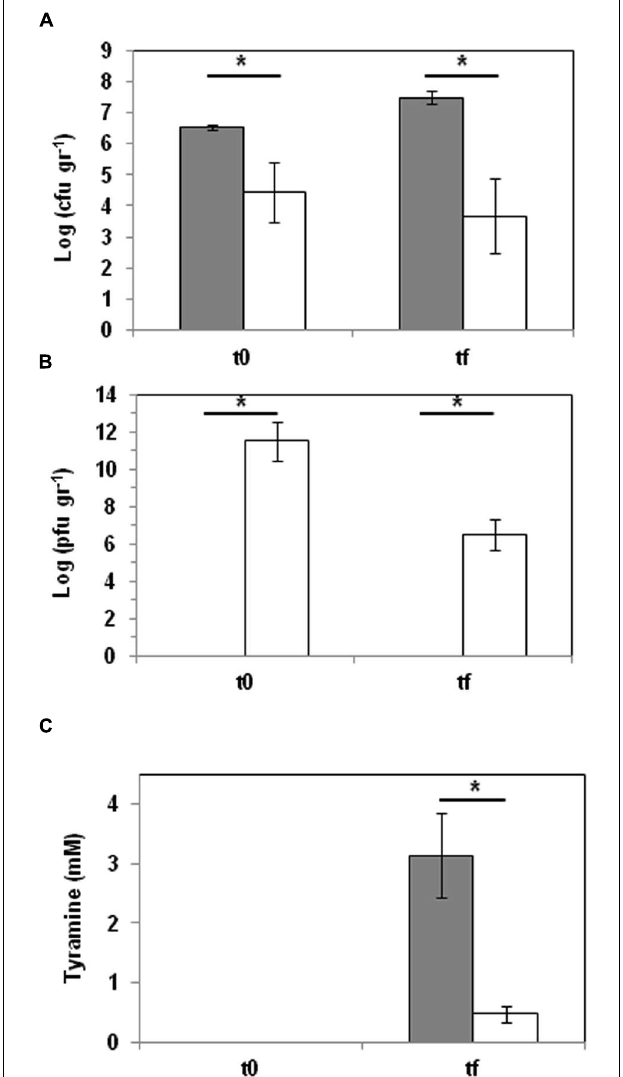
FIGURE 4 | Phage biocontrol assay in a small-scale cheese model. E. faecalis was challenged with phage Q69 at an MOI of 0.1 (dark gray bar = control cheeses inoculated with E. faecalis 23a; white bar = cheeses inoculated with E. faecalis 23a and challenged with phage Q69). (A) Number of E. faecalis cells (log cfu ml − 1 ) after manufacturing (t0) and after 60 days of ripening (tf), as calculated by qPCR. (B) Number of Q69 phage particles (log pfu ml − 1 ) after manufacturing (t0) and after 60 days of ripening (tf). (C) Tyramine concentration (mM) measured by UPLC after manufacturing (t0) and after 60 days of ripening (tf). An asterisk indicates a significant difference ( ∗ p < 0.05; Student’s t -test) with respect to control